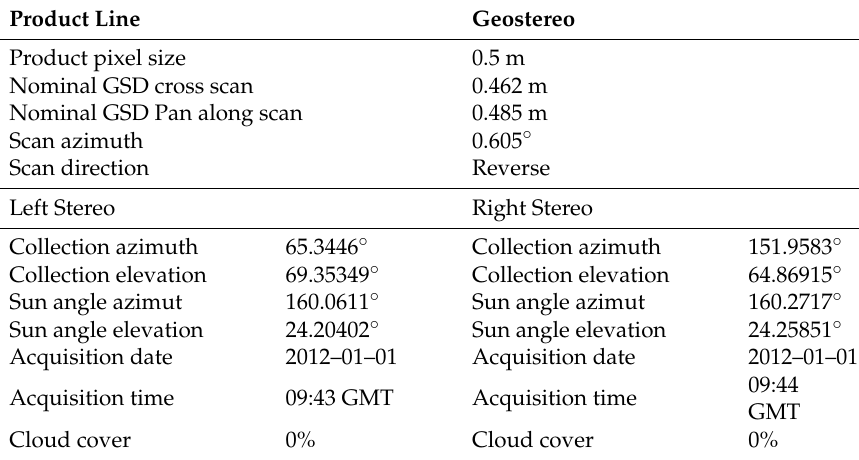
Table 2. Characteristics of the GeoEye-1